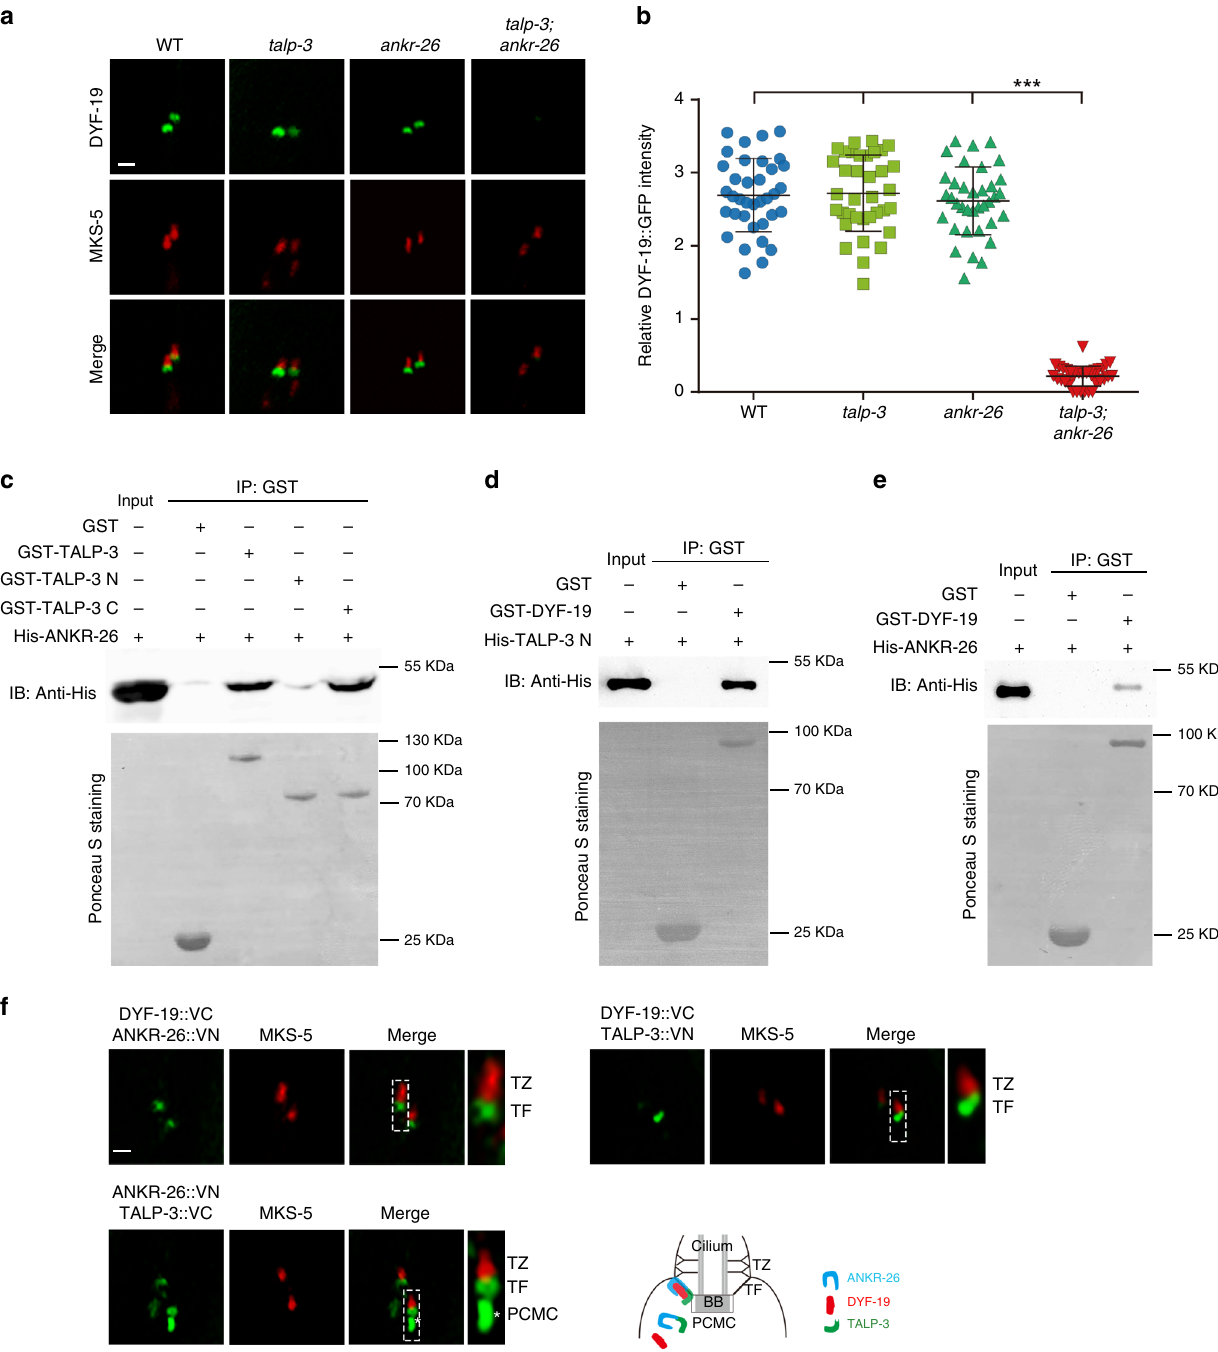
Fig. 3 TALP-3 and ANKR-26 cooperate to recruit the transition fi ber protein DYF-19. a Localization of the transition fi ber protein DYF-19 to the basal body is disrupted in the talp-3; ankr-26 double mutant. b Quanti fi cation of relative DYF-19 fl uorescence intensity in WT, talp-3 single mutant, ankr-26 single-mutant, and talp-3; ankr-26 double-mutant worms. Data are presented as the mean value ± s.d. n = 36. ***, P < 0.001 by two-tailed unpaired Student ’ s t test. c TALP-3 directly interacts with ANKR-26. A GST pulldown assay was used to detect the interaction between His-fused ANKR-26 and GST-fused full-length TALP-3 and truncated TALP-3 constructs (N-terminus, amino acids (aa) 1 – 450; C-terminus, aa 354 to the C-terminal end). Upper panel, blotted with anti-His antibody; lower panel, loading of the GST and GST-TALP-3 proteins shown by Ponceau S staining. d TALP-3 directly interacts with DYF-19 in a GST pull-down assay. e ANKR-26 directly interacts with DYF-19 in vitro. f TALP-3, ANKR-26 and DYF-19 interact in vivo on TFs. The BiFC assay was performed to visualize the in vivo interaction between TALP-3, ANKR-26, and DYF-19 in living worms. Stable fl uorescence complementation between the ANKR-26::VN and TALP-3::VC pair, the ANKR-26::VN and DYF-19::VC pair, and the TALP-3::VN and DYF-19::VC pair was observed on TFs. Notably, strong BiFC signals for ANKR-26::VN and TALP-3::VC are observed in the PCMC region. Scale bars = 1 μ m. Source data are provided as a Source Data fi